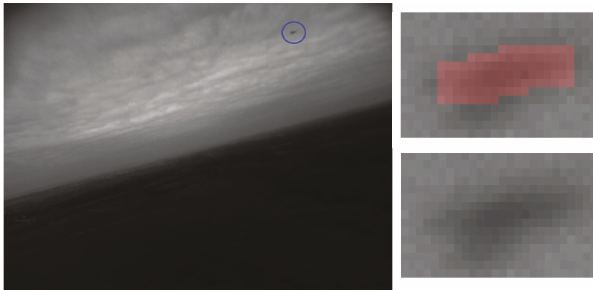
Figure 12: Aircraft detection. The red region in the enlarged image shows the object mask from